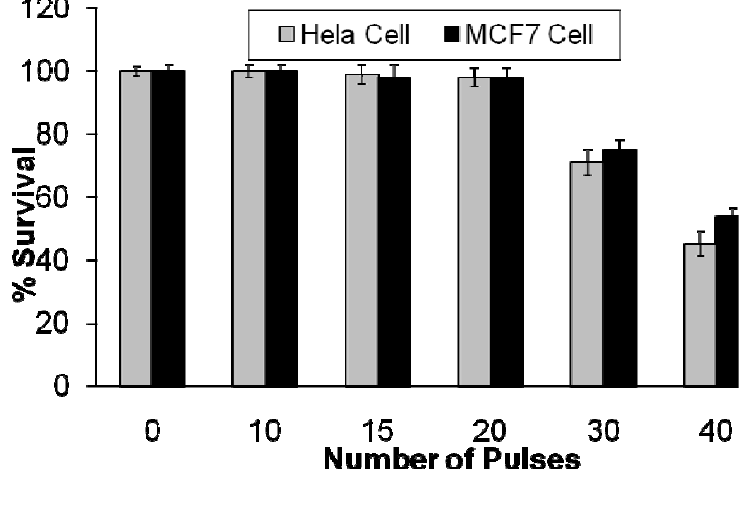
Figure 10. The percentage survival of HeLa and MCF7 cell lines following exposure to different number of IPL pulses with the following properties: Operating mode: single; Spot size: 8 mm × 15 mm; Fluency: 15 J/cm 2 ; Filter (wavelength): 560 nm; Pulse duration: 3 milliseconds